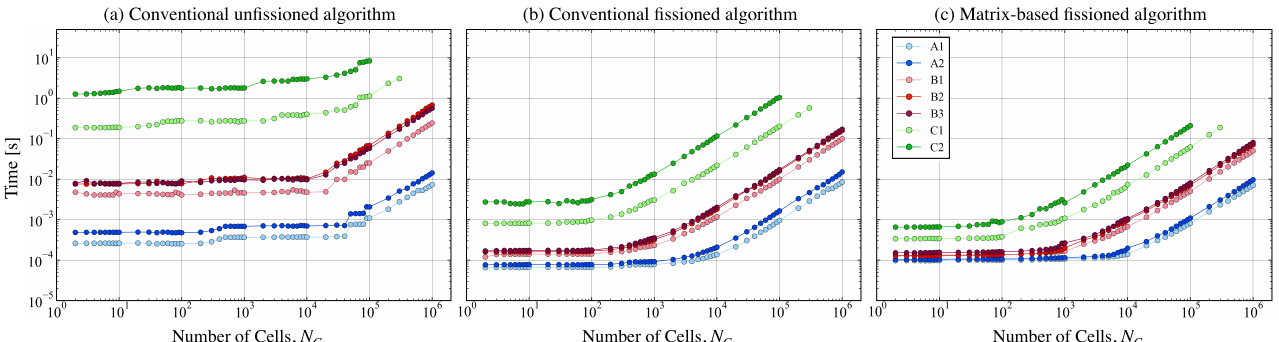
Figure A4. GPU source term evaluation times for: ( a ) the conventional unfissioned algorithm; ( b ) the conventional fissioned algorithm; and ( c ) the matrix-based fissioned